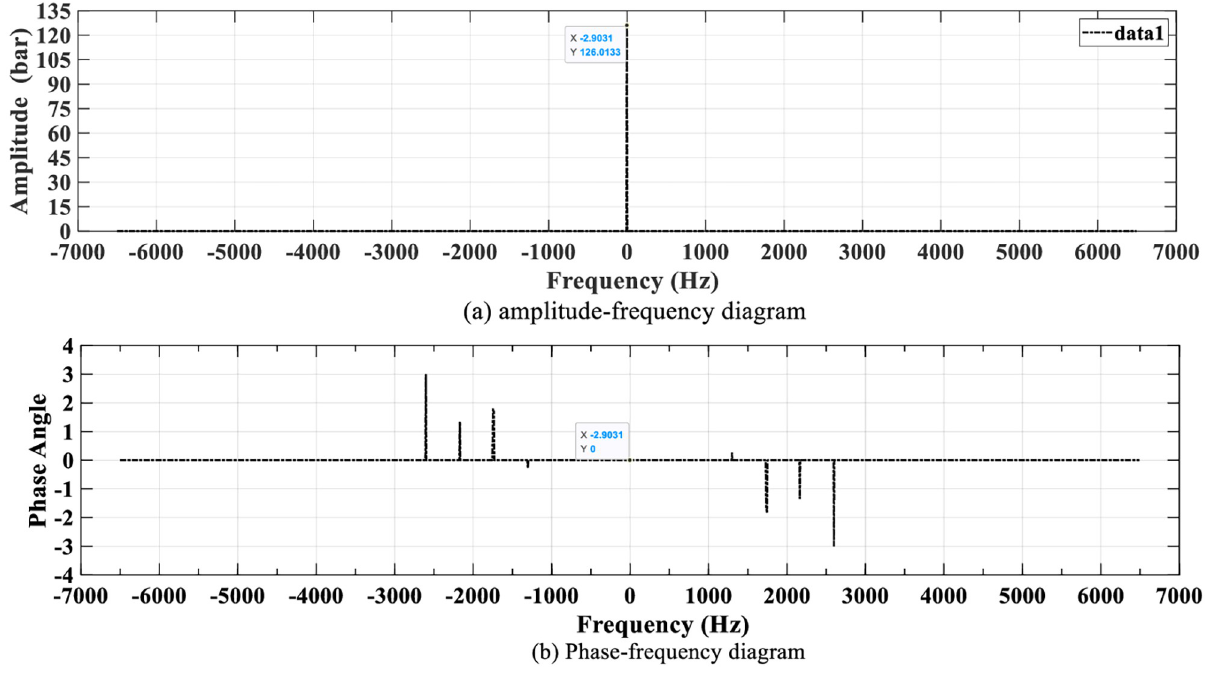
Fig 20. Spectrogram of simulation instantaneous pressure. (a) amplitude-frequency diagram and (b) Phase-frequency diagram.